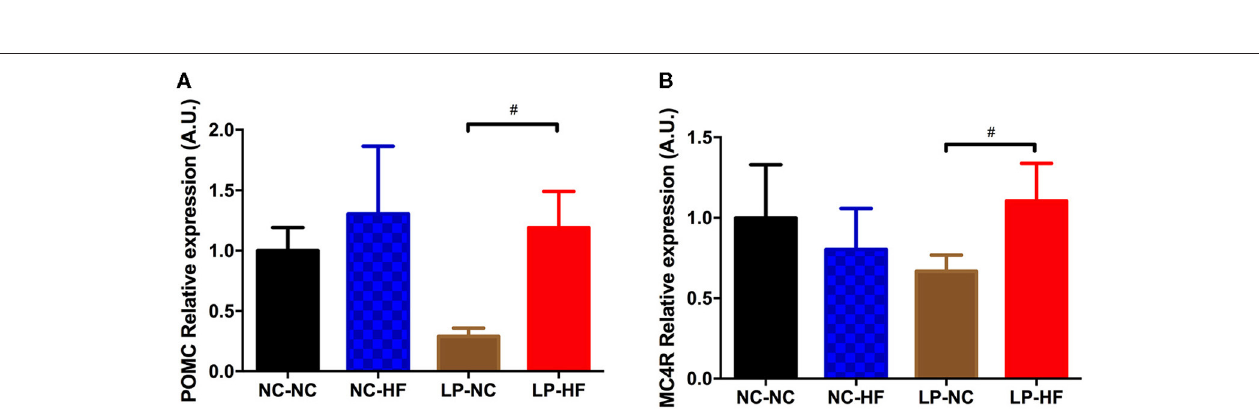
FIGURE 4 | Effects of maternal protein restriction and post-weaning high-fat feeding on hypothalamic gene expressions in offspring. (A) POMC; (B) MC4R. Data were represented as mean ± SEM ( n = 6–8/group). # P < 0.05 LP–HF vs. LP–NC group. Diet abbreviations: NC, normal chow; LP, low protein; HF, high fat. Dam and pup diets denoted before and after the dash line, respectively.